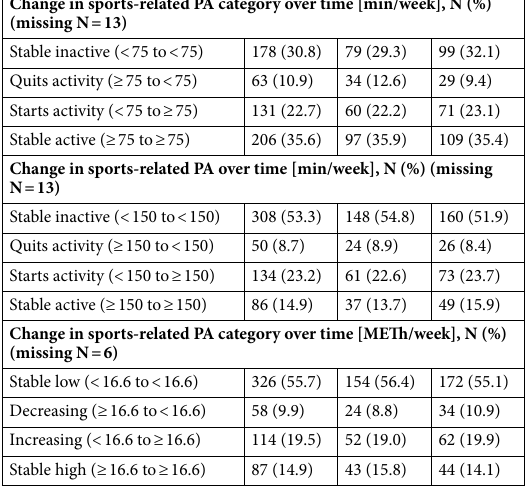
Table 2. Frequencies with regard to PA change variables from study entry to the latest follow-up examination. METh metabolic equivalent hours, min minutes, N number of participants, PA physical